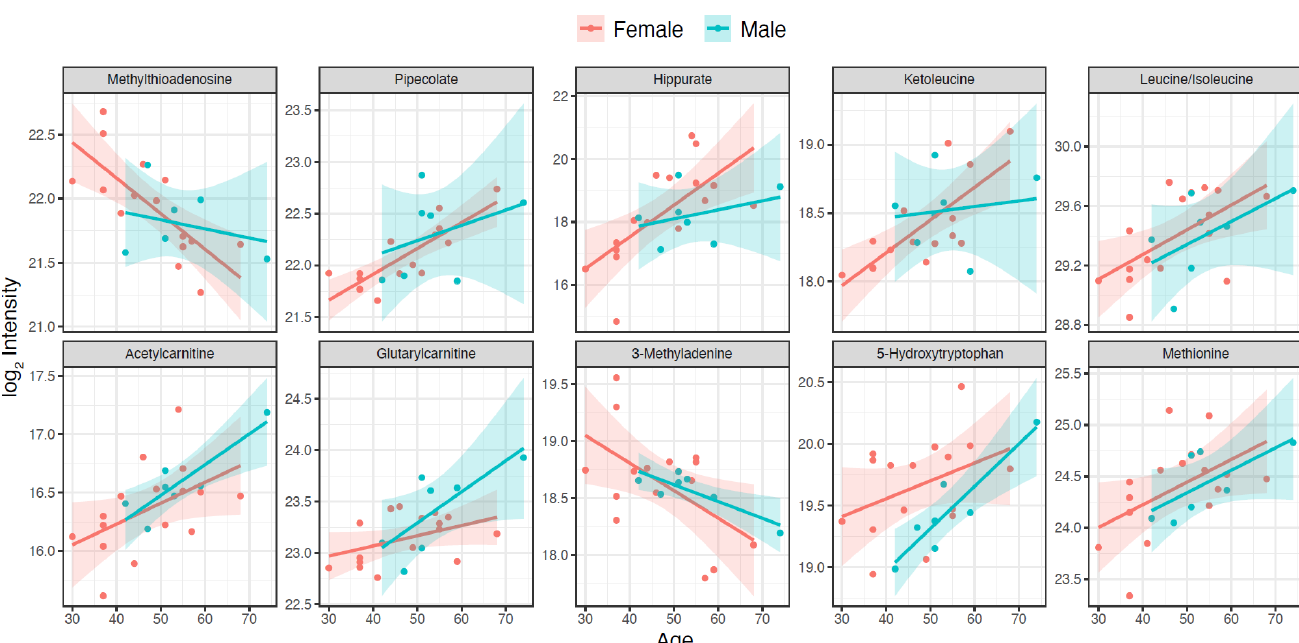
Figure 2. Metabolites significantly associated with age (q < 0.1) in CSF from healthy subjects. Value refers to log 2 transformed peak areas and age is given in years. The colored zones refers to 95% confidence intervals of the regressions.